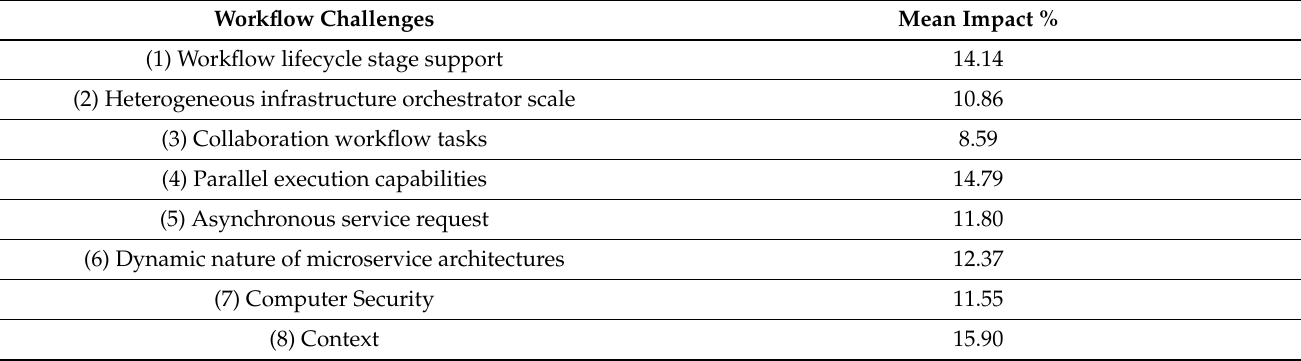
Table 3. Criteria Impact on decision (mean priorities by criterion